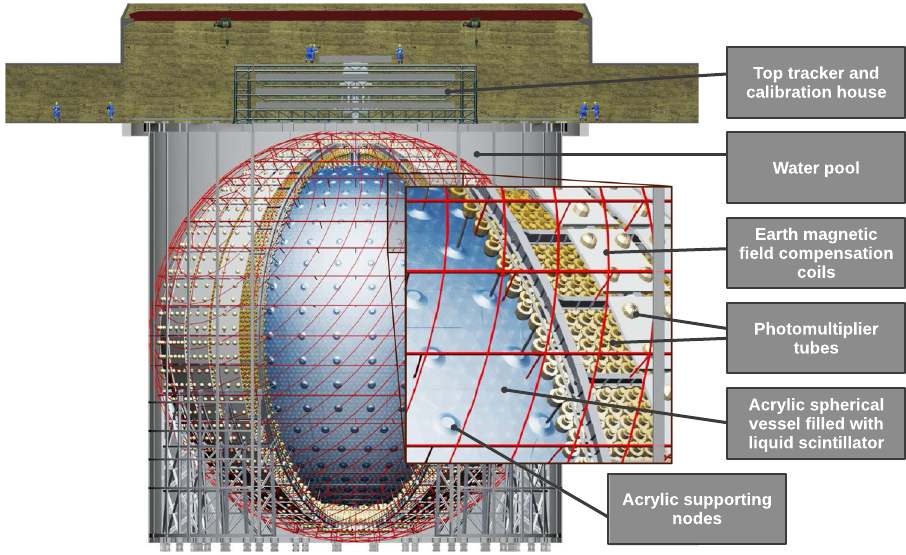
Fig. 1 Schematic view of JUNO detector and other main